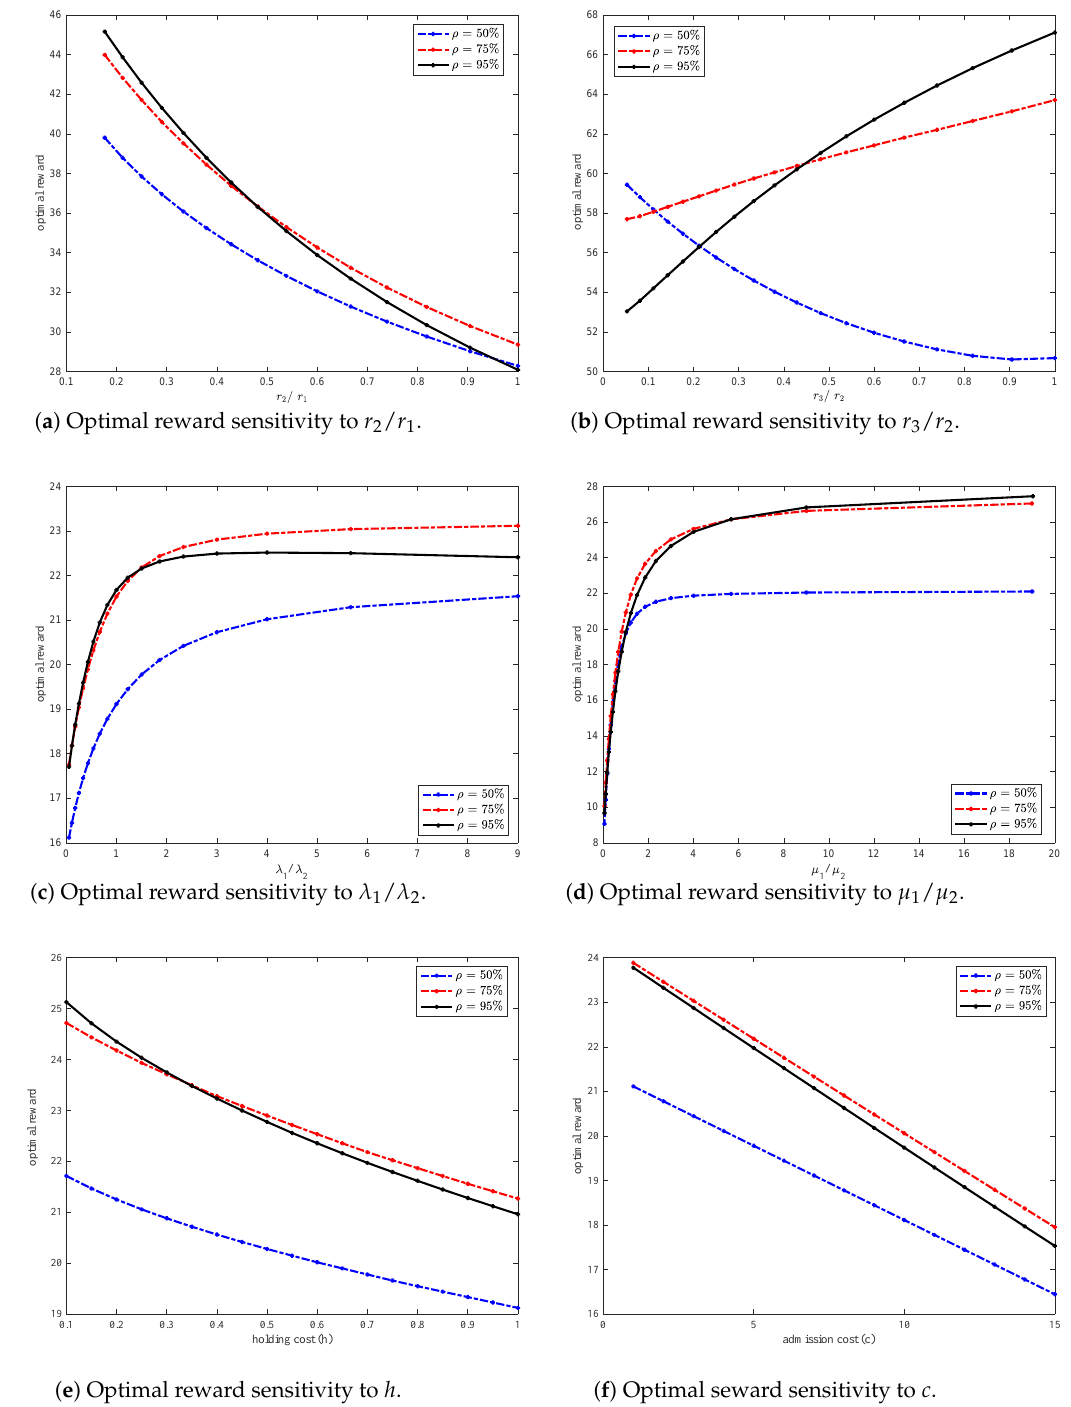
Figure 4. Optimal reward sensitivity to rewards r 1 , r 2 , r 3 , service rates µ 1 , µ 2 , arrival rates λ 1 , λ 2 , holding cost h and admission cost c